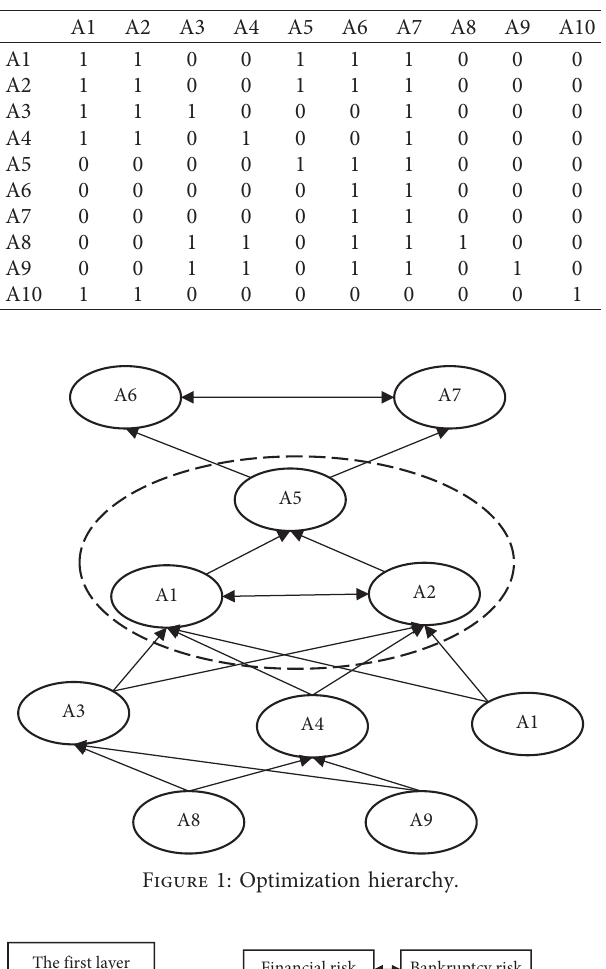
Table 1: Adjacency matrix.